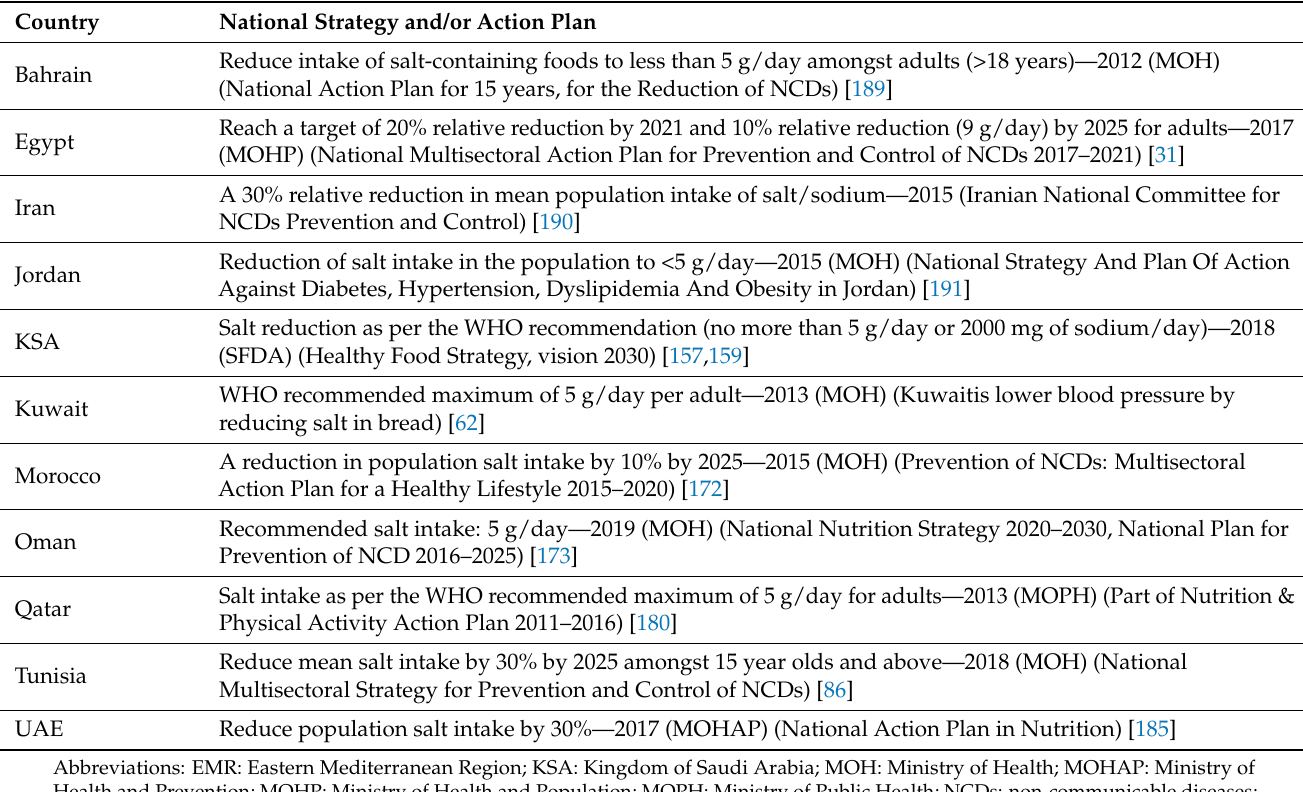
Table 2. National salt reduction strategies or action plans identified in countries of the